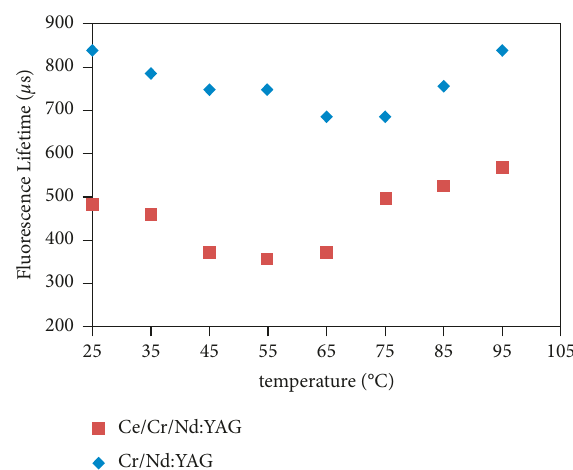
Figure 7: Dependence of temperature on fluorescence